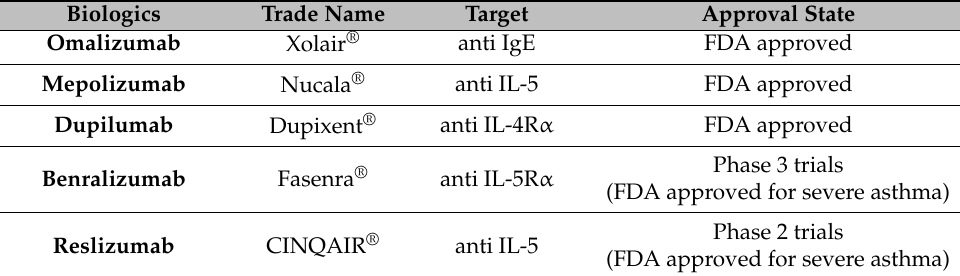
Table 3. Biologics for the target of CRS and approval